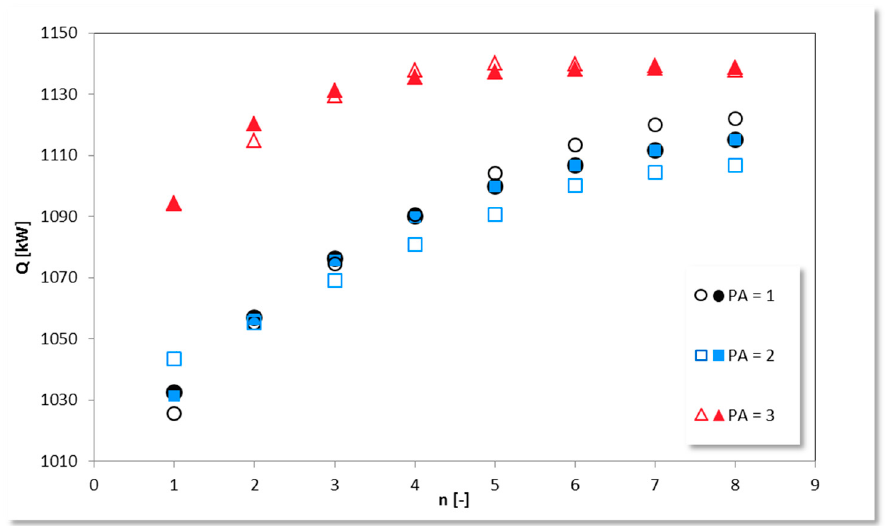
Figure 7. The dependence of the heat transfer rate Q desired (blank symbols) and predicted (filled symbols) with the number of flooded tube rows (KT = 4, m = 5.75 kg/s).